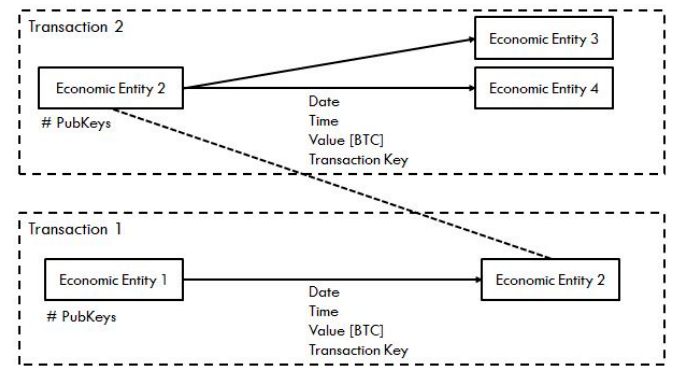
Figure 4. Bitcoin Entity Network.